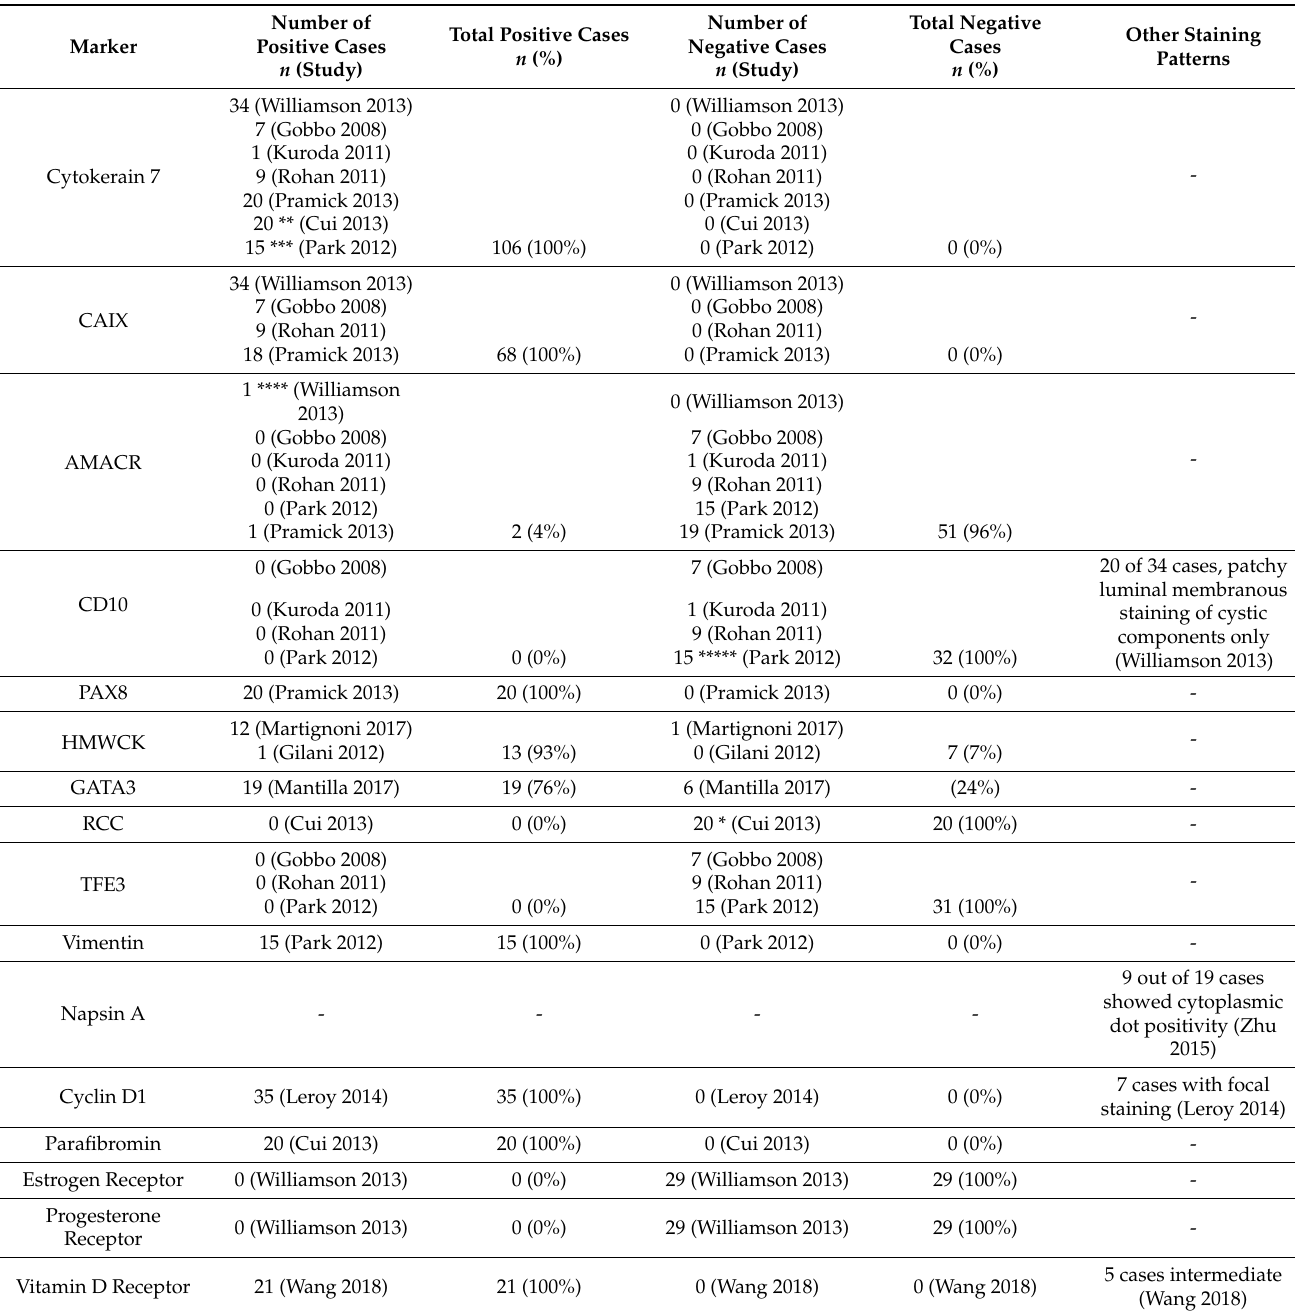
Table 4. Immunohistochemical markers in ccpRCC